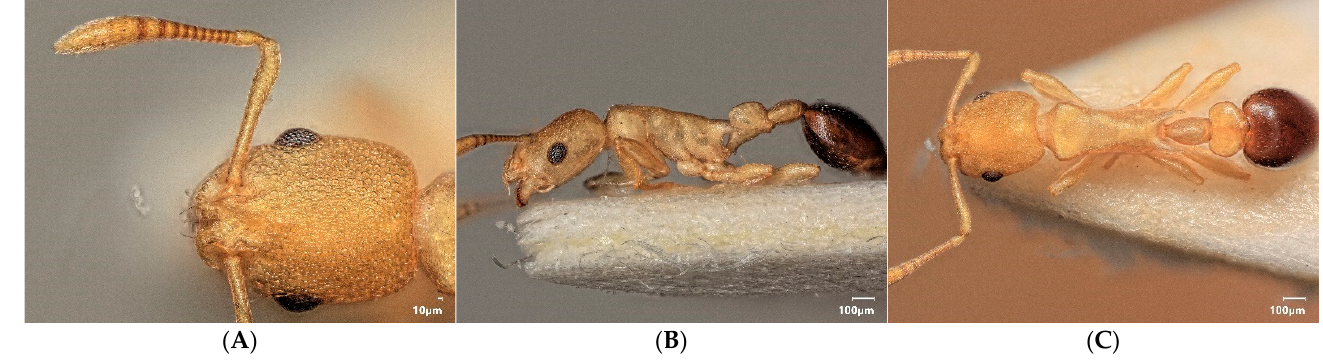
Figure 21. Cardiocondyla nigrocerea : head in dorsal view: ( A ), lateral view ( B ), dorsal view ( C ).